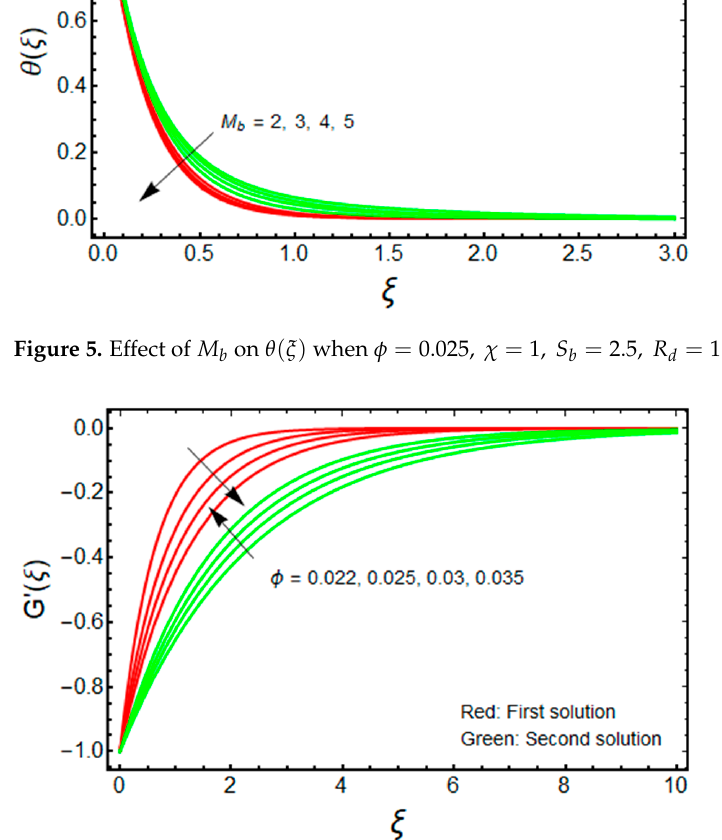
Figure 6. Effect of φ on G (cid:48) ( ξ ) when S b = 2.5, χ = 1, M b = 0.5.